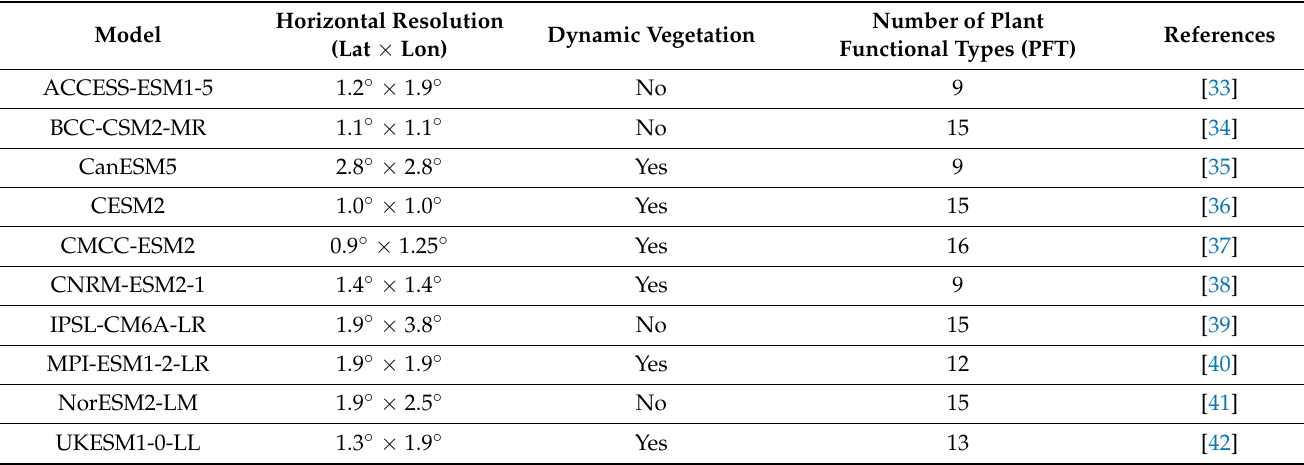
Table 2. A brief description of CMIP6 models used in this